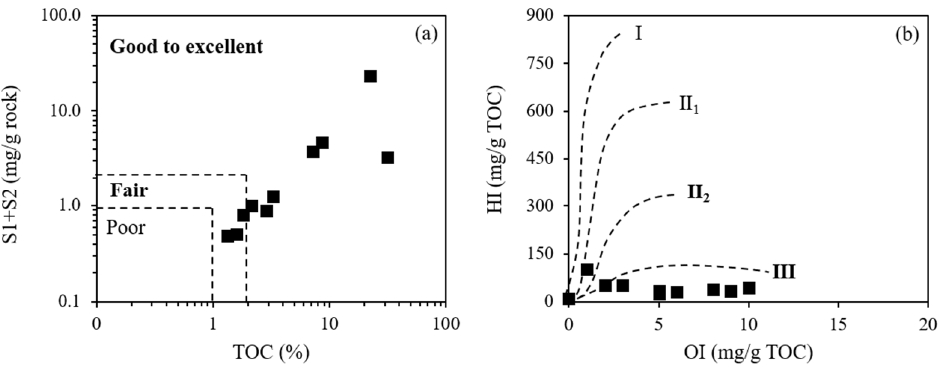
Figure 2. Bulk geochemical data of source rock samples from well Chaiye 2: ( a ) S1 + S2 vs. TOC; ( b ) HI vs. OI. Table 3. Measured Ro values of source rock samples from well Chaiye 2. Depth